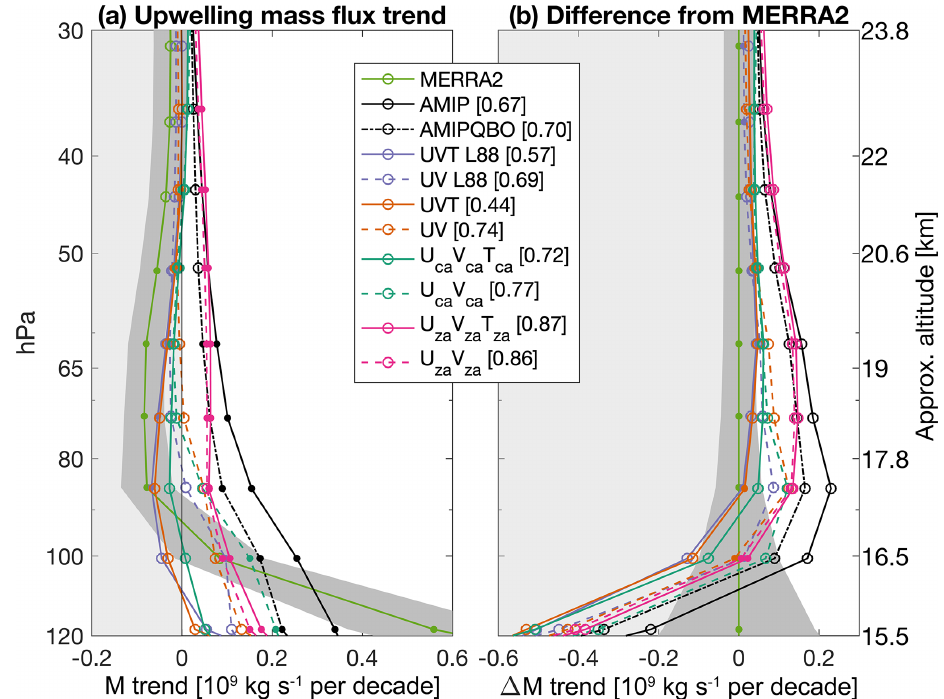
Figure 3. Upwelling mass flux (a) trends and (b) trend differences from MERRA2. Shading indicates the 95% confidence interval on the MERRA2 trends. Numbers in the legend indicate the correlation coefficient squared between each simulation’s trends and the trends in MERRA2. Open circles in (a) indicate trends not statistically significant at the 95% confidence level, while open circles in (b) indicate trends statistically significantly different from MERRA2 at the 95% confidence